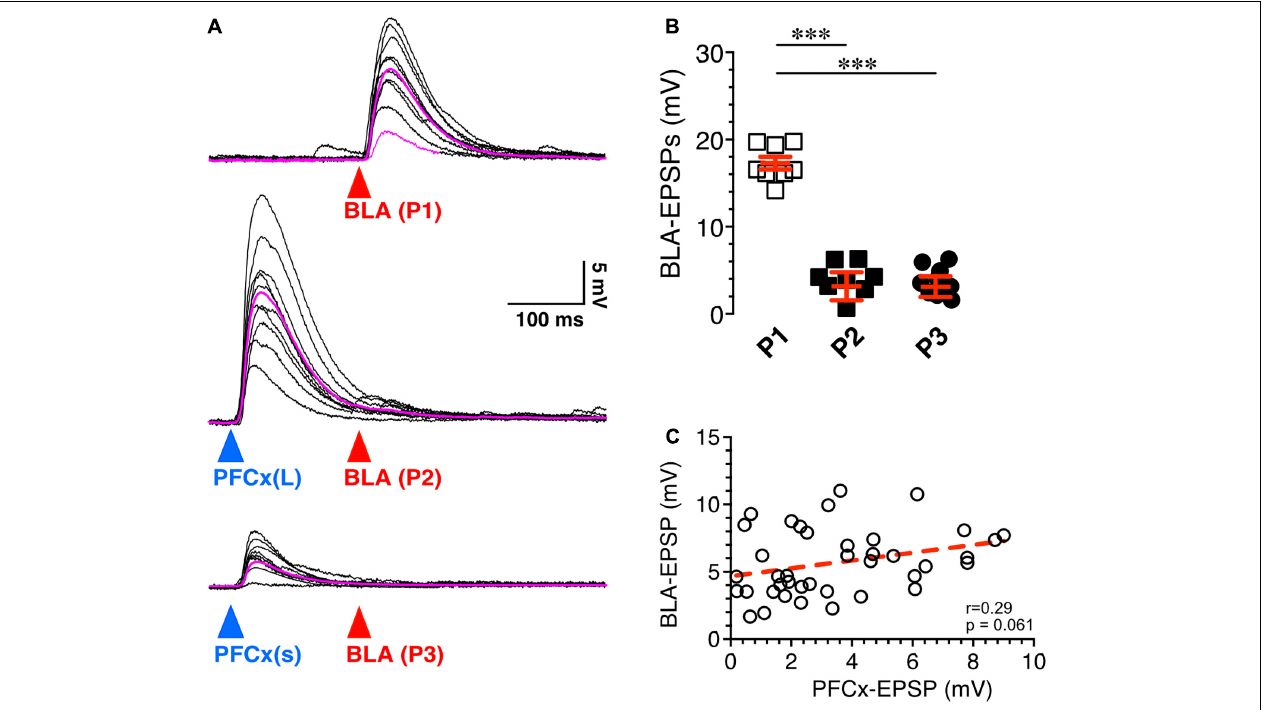
FIGURE 3 | Synaptic gating is a sensitive phenomenon. (A) Ten overlaid BLA EPSPs (red arrowhead) evoked in absence (top traces) and in presence of large (middle traces) and small (bottom traces) PFCx-EPSPs (blue arrowheads) in the same MSN ( n = 8). Purple traces show averaged EPSPs. (B) Amplitude of BLA-EPSPs in absence (open squares) and in presence of large (solid black squares, P2) and small (solid circles, P3) PFCx-EPSPs. (C) Relationship between amplitude of BLA-EPSPs as a function of PFCx-EPSPs amplitudes. Average values in graphs are expressed as mean ± standard error (SEM). ∗∗∗ p <